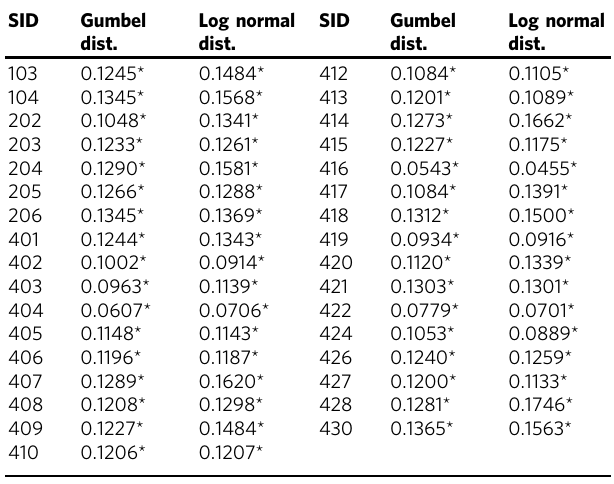
The correlation coef fi cients r for the pooled simulated series per subject using two skewed distributions for the random fl uctuations in value, the Gumbel and log normal (* p <10 − 10